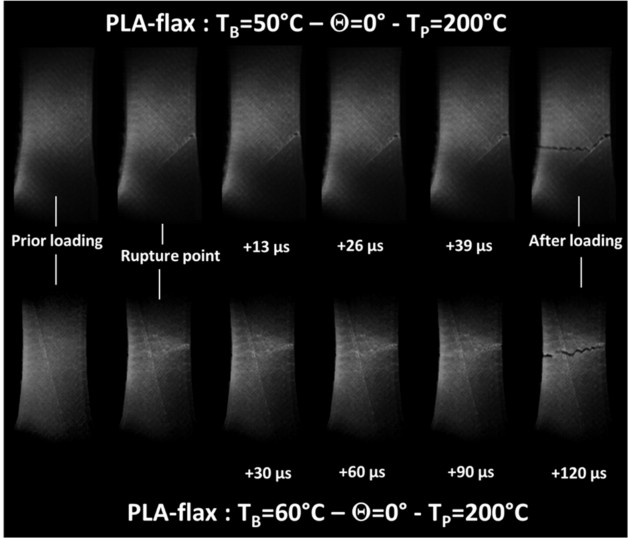
Figure 5. Cracking behaviour captured at 33k–42k fps of the deformed PLA-flax for two bed temperatures ( Θ = 0 ◦ , T P = 200 ◦ C).